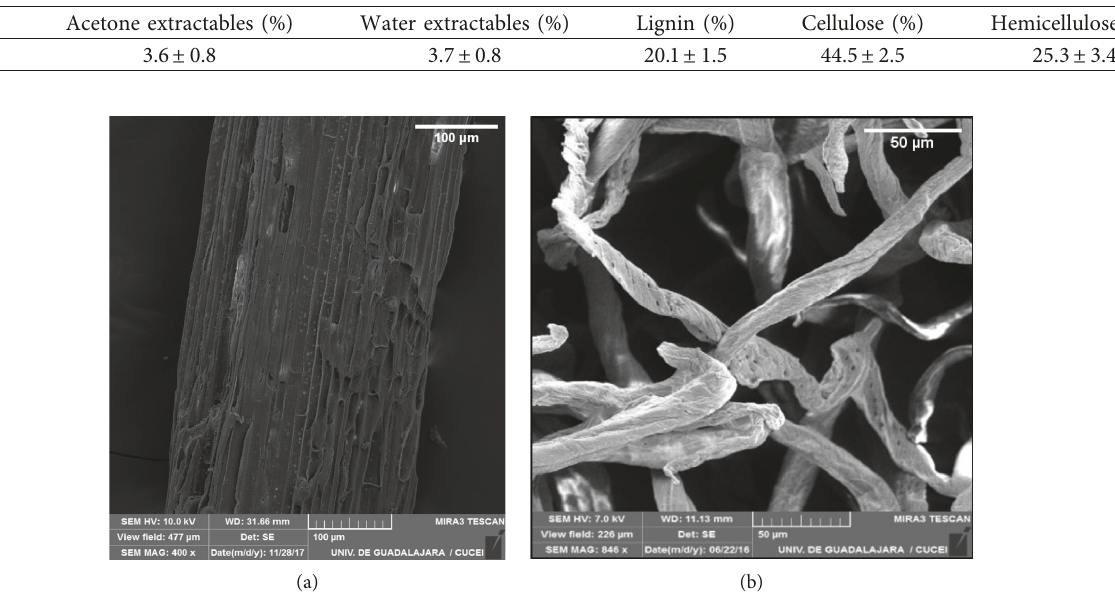
Figure 1: Morphology of agave cellulose fiber: (a) without treatment 100 μ m; (b) treated with organosolv method 50 μ m.